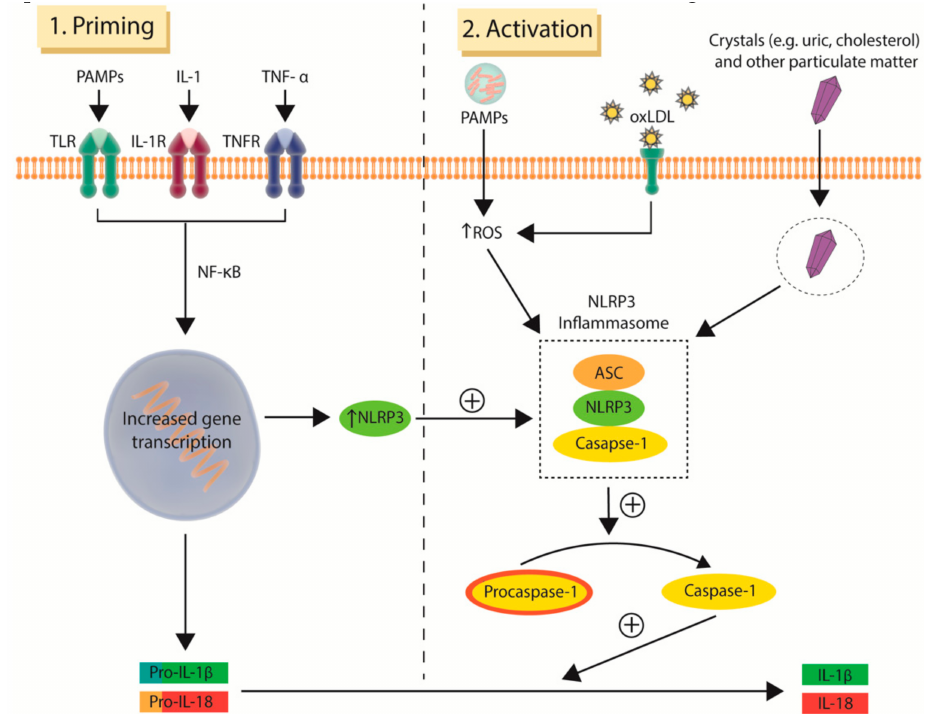
Figure 3. Two signal activation of the NOD-like receptor family pyrin domain containing 3 (NLRP3) inflammasome. Activation of the NLRP3 inflammasome requires both the initial priming step (left) following by the activation step (right). Priming of macrophages is provided by endogenous cytokines (IL-1 and TNF- α ) and binding of PAMPs on microbial molecules to membrane-bound TLR. The second activation step involves a variety of stimuli, including intracellular oxLDL accumulation, PAMPs, and crystalloid particulates such as uric and cholesterol crystals. The NLRP3 inflammasome catalyses the conversion of pro-caspase-1 to its active form, caspase-1, which then converts pro-IL-1 β and pro-IL-18 into their bioactive, pro-atherogenic forms, IL-1 β and IL-18. ASC, apoptosis-associated speck-like protein; IL-1, interleukin 1; IL-1R, interleukin-1 receptor; NLRP3, NOD-like receptor family pyrin domain containing 3; oxLDL, oxidised low-density lipoproteins; PAMPs, pathogen-associated molecular patterns; ROS, reactive oxygen species; TLR, toll-like receptors; TNF- α , tumor necrosis factor alpha; TNFR, tumor necrosis factor